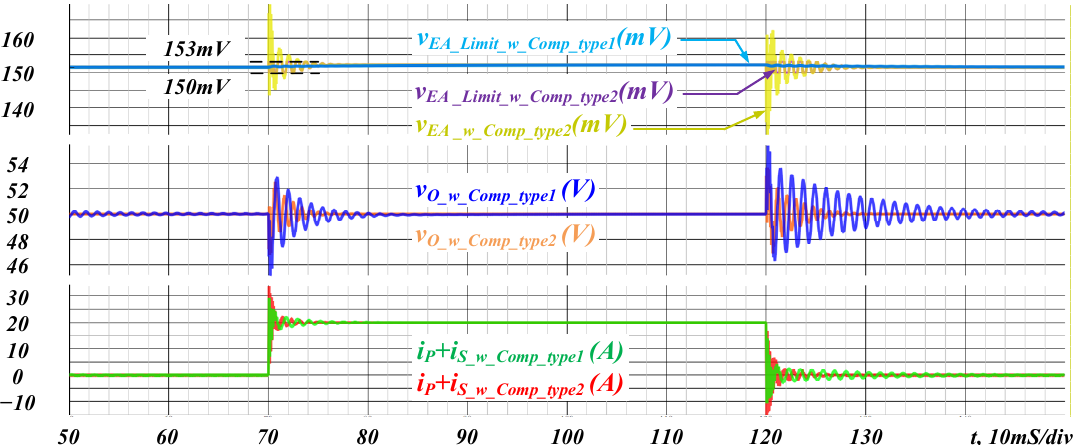
Figure 26. Comparison of the simulation results of the system transient response of the first and second compensators.